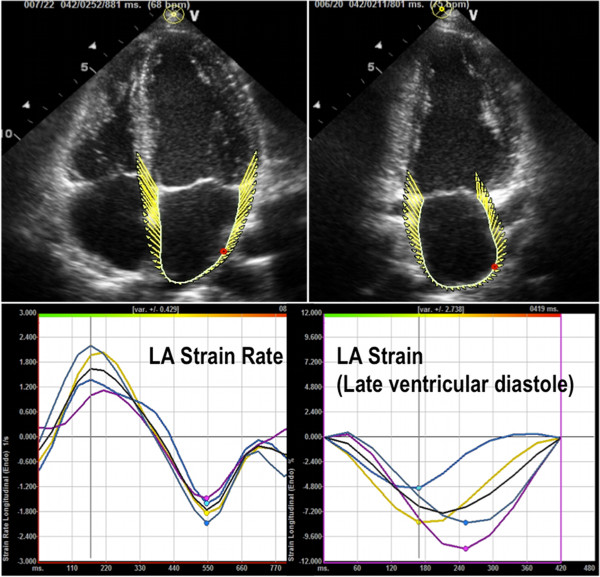
Velocity vector imaging for left atrial strain and strain rate in the apical 4-chamber (left images) and apical 2-chamber (right images) views. The right lower image is an example of LA strain during atrial systole and the left lower image is an example of LA strain rate curves. In the left lower image, the black line represents the global LA strain rate during LV systole, early and late diastole. The colored lines represent the strain rates of the two annular and mid segments of the LA. The right lower image shows the global and segmental LA strain during atrial systole (late ventricular diastole).